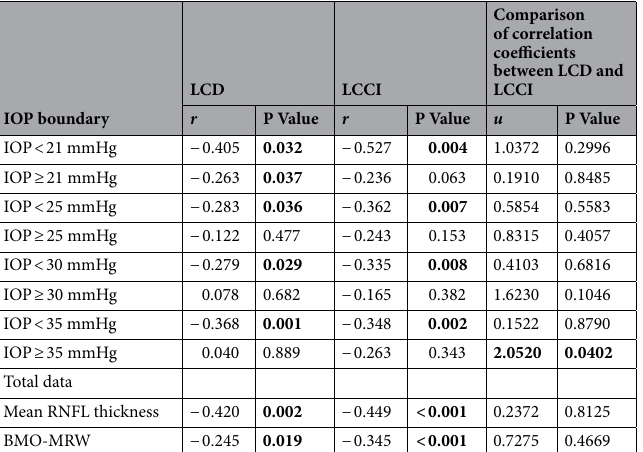
Table 4. Pearson correlation of LCD, LCCI and RNFL thickness. BMO-MRW = Bruch’s membrane opening minimum rim width; IOP = intraocular pressure; LCCI = lamina cribrosa curvature index; LCD = lamina cribrosa depth; RNFL = retinal nerve fiber layer. All values < 0.05 at Pearson correlation analysis are presented in boldface. The u value more than 1.96 (P < 0.05) was considered to be statistically significant.